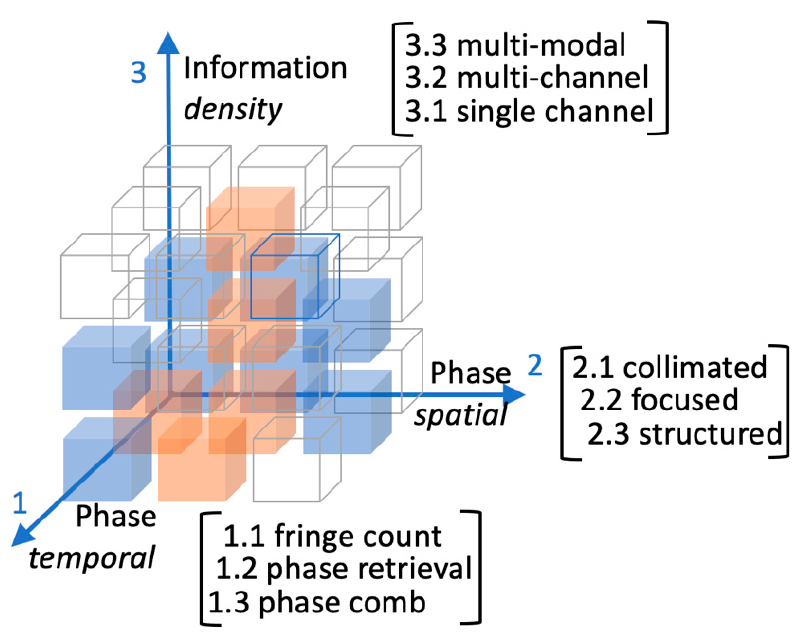
Figure 1. A suggestive drawing of the optical feedback (OF) development space. Axes 1 and 2 measure the information increase due to improving temporal and spatial resolution. Along axis 3 the information content achievable with more sophisticated OF setups. Blue cubes make the content of this article. Orange cubes are regions explored by other groups cited in the text.